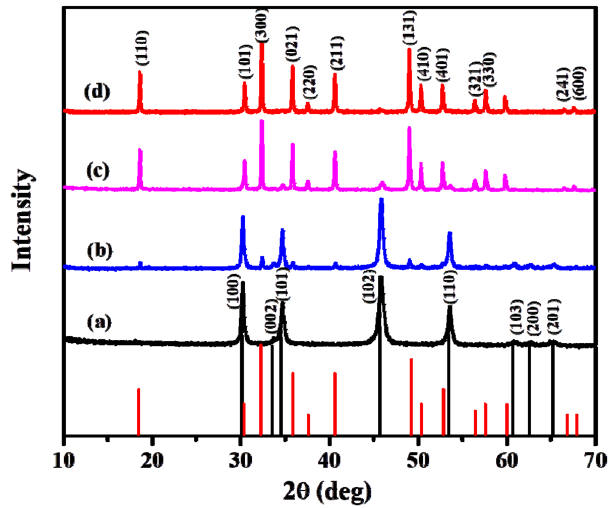
Figure 1. p-XRD patterns of NiS nanoparticles synthesized from complex ( 1 ) at ( a ) 200 °C (ICDD # 03-065- 3419), ( b ) 300 °C, ( c ) 350 °C and ( d ) 400 °C (ICDD #